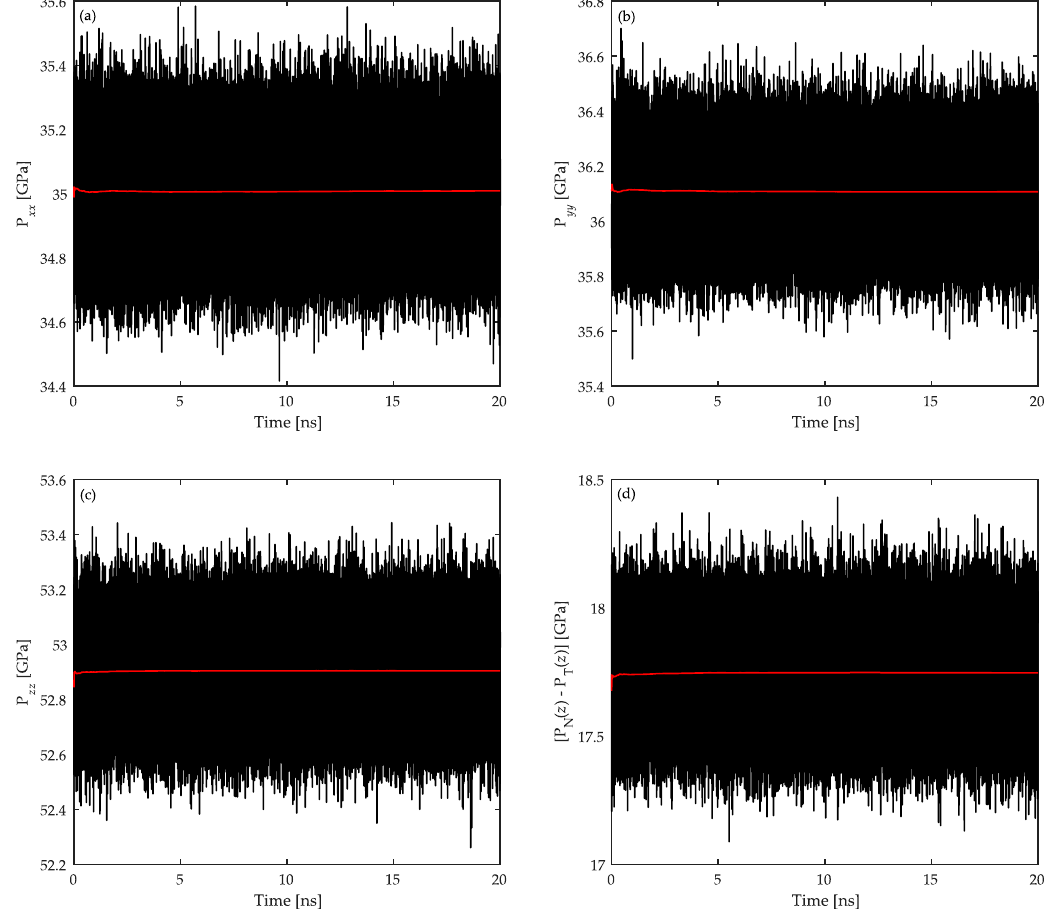
Figure 9. Instantaneous ( black curve) and running average (red curve) profiles of ( a ) P xx ( z ); ( b ) P yy ( z ); ( c ) P zz ( z ); and ( d ) (cid:4670) P N ( z ) - P T ( z ) (cid:4671) . These data are calculated for polymer atoms in the interfacial regions of the confined PP/Fe 2 O 3 system at 458 K and 1 atm.